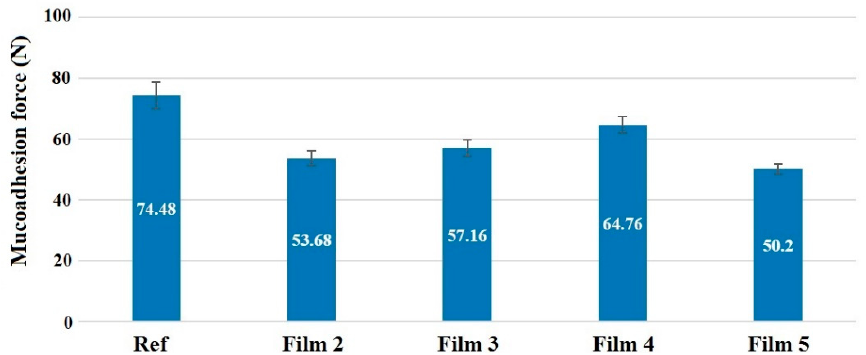
Figure 4. Mucoadhesion force of the films prepared with acetic acid (Ref) and different concentrations of ascorbic acid.